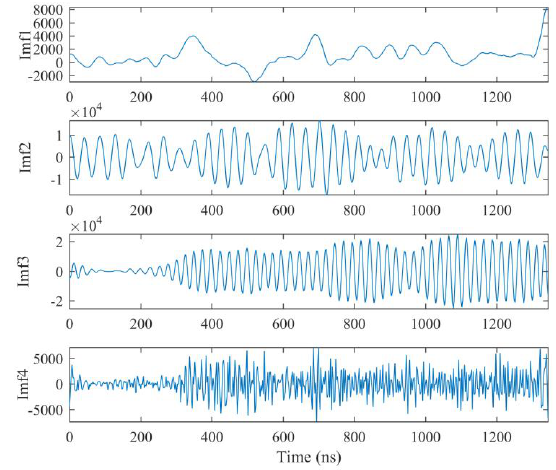
Figure 13. The decomposed IMFs using VMD.